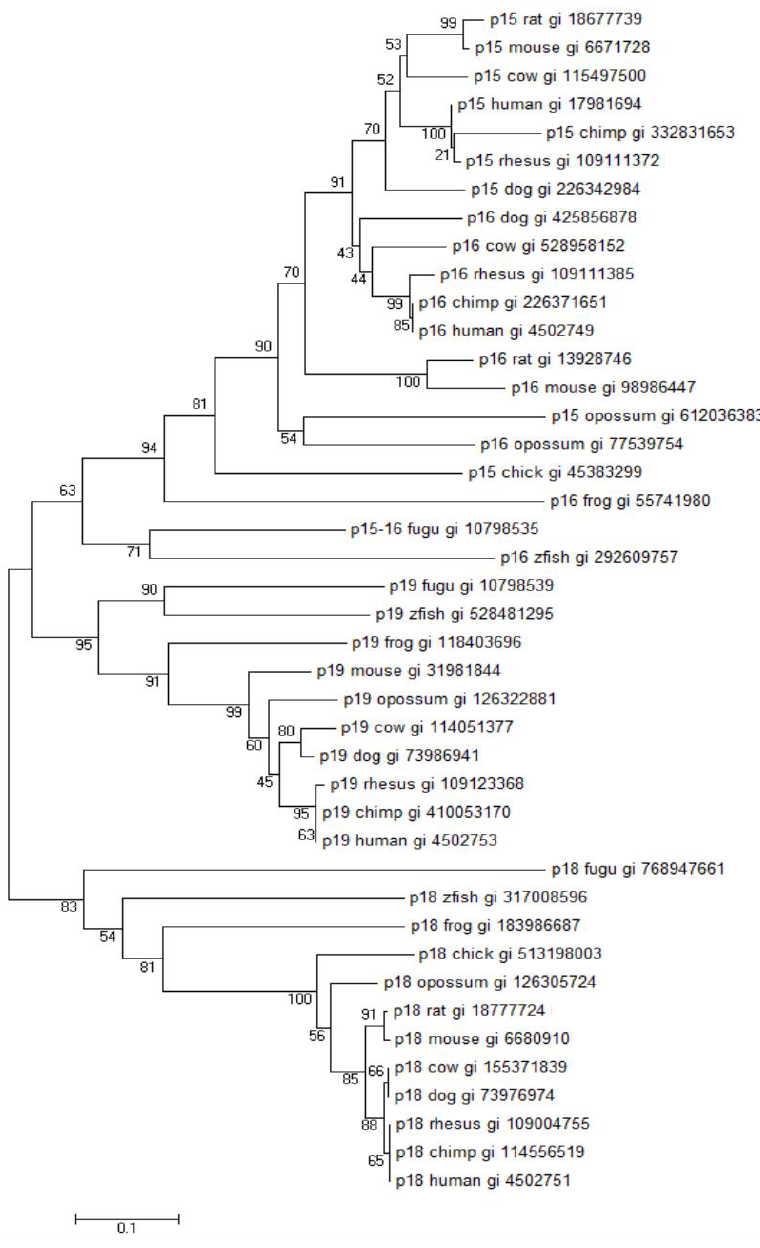
Figure 2. INK4/CDKN2 family tree. Annotated INK4 proteins from select organisms were aligned using Clustal W. The alignment was used to construct a neighbor-joining phylogenetic tree (applying complete deletion of gaps and Poisson model rates and patterns; MEGA6). Bootstrap